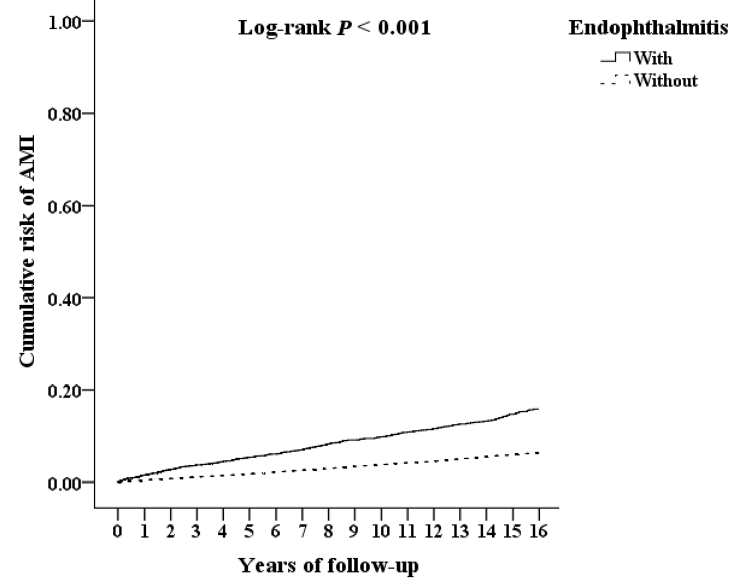
Figure 3. Kaplan–Meier survival curve of the cumulative risk of AMI in AS patients with and without endophthalmitis.